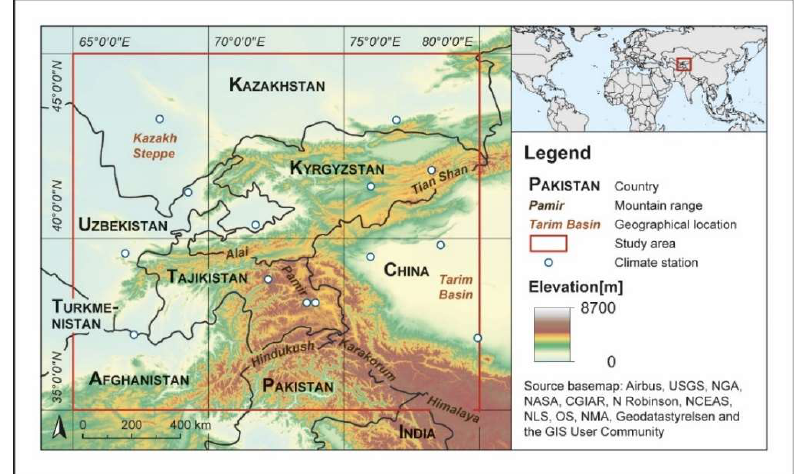
Figure 1. The research area and its geographical and topographical features, including the location of the meteorological stations used for the dataset validation.